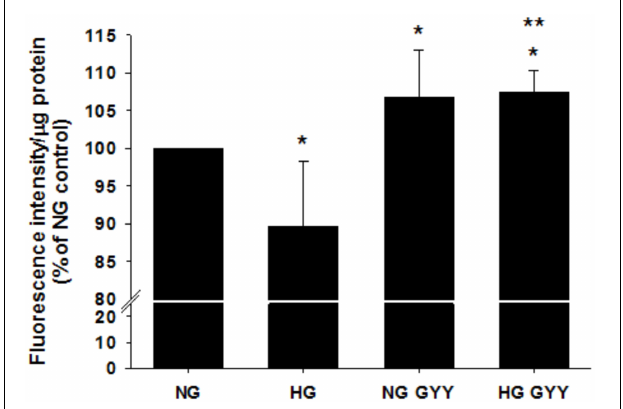
FIGURE 2 | Administration of the slow-release H 2 S donor NaGYY4137 completely reversed the loss of retinal EC glycocalyx integrity induced by hyperglycemia. Retinal ECs were incubated with normal (5.5 mmol/L, NG) or high glucose (25 mmol/L, HG) ± GYY4137 (500 µ mol/L) for 24 h before assessment of glycocalyx integrity with fluorescently labeled lectin (WGA-FITC). Data are mean ± SD, presented as fluorescence intensity/ µ g protein. * p ≤ 0.01 vs. control, ** p ≤ 0.01 vs. HG, n = 12–30. One-way